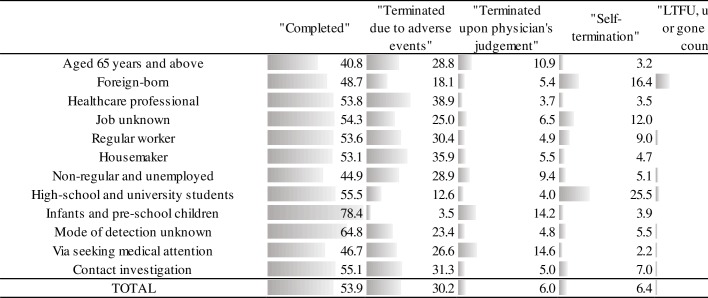
Reasons for terminating LTBI treatment among selected population groups, 2012–2014.The figure shows reasons for terminating LTBI treatment among those who did not meet the criteria of “treatment completion” of our study, stratified by their risk group. TOTAL: The total is not the sum of the specific population groups listed above, but is the total number those who did not meet the criteria of the study definition of “treatment completion”. “Completed”: The physician has judged that the treatment has been completed, despite treatment duration not reaching 180 days. “Terminated upon physician’s judgement”: the physician has terminated the treatment for reasons other than treatment completion and adverse events. “LTFU”: Lost to follow-up.